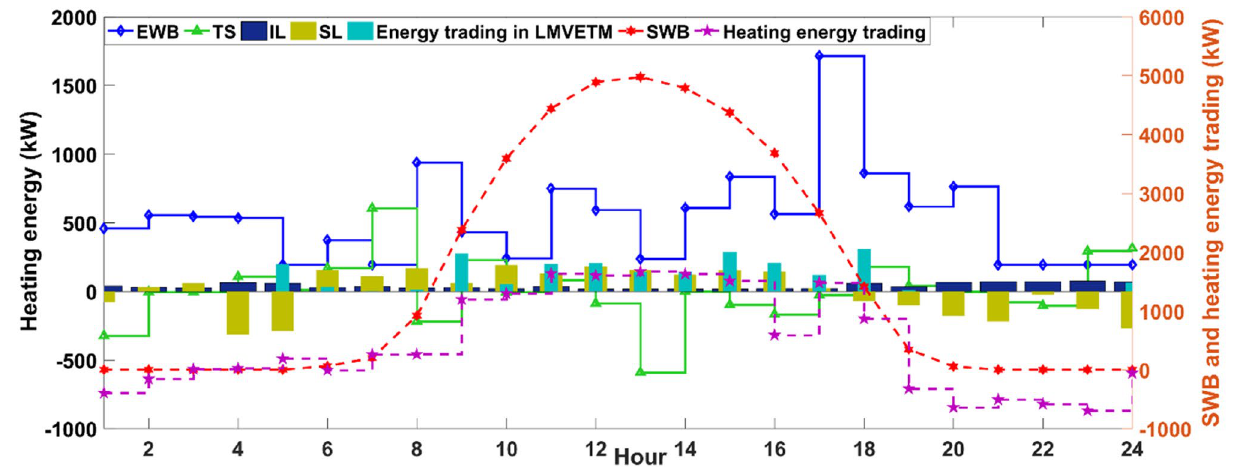
Figure 5. Optimal scheduling of the DHN systems. It is a depth of indication for the operation of DHN systems in the modern structure of multi-energy